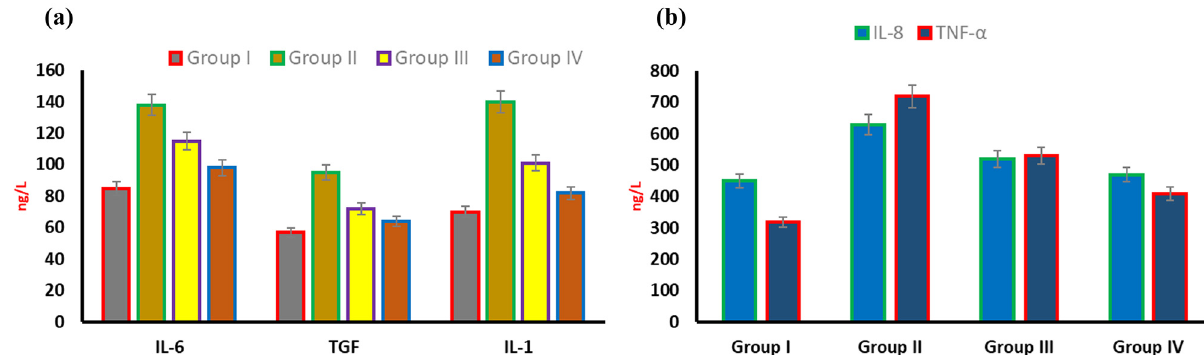
Figure 7: E ff ects of AuNPs on BALF cytokines in mice. ( a ) Levels of IL - 6, TGF and IL - 1 and ( b ) levels of IL - 8 and TNF - α .